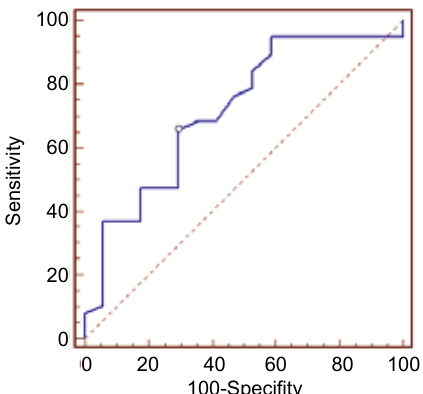
Figure 3 ROC analysis of CT scanning score for prediction of imported history. N = 55; AUC = 0.714, 95% CI: 0.576-0.827.